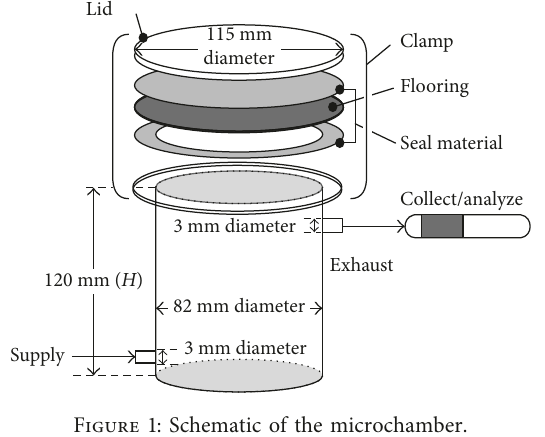
Figure 1: Schematic of the microchamber.